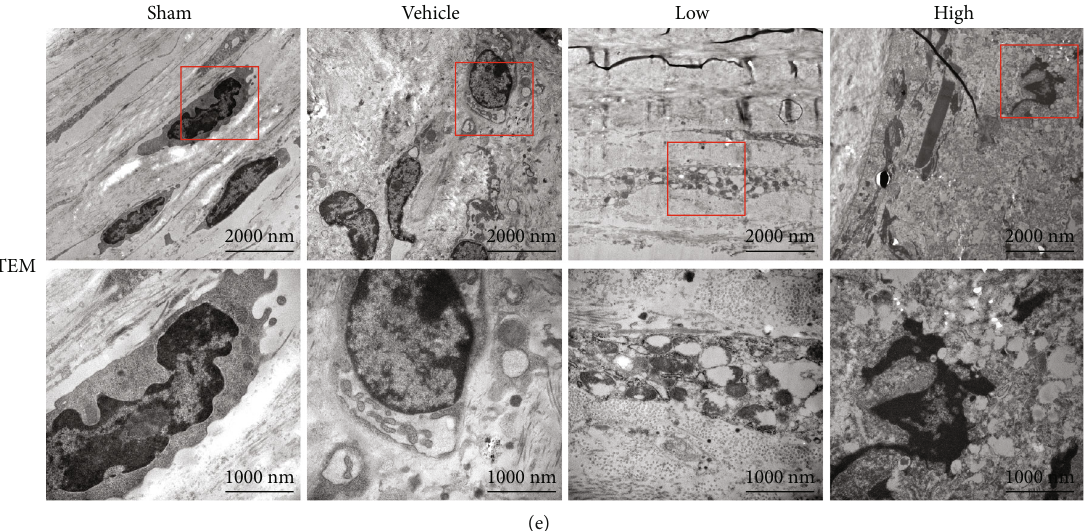
Figure 2: Tetrandrine (Tet) prevents Ti particle-induced chronic in fl ammation and osteolysis in vivo . (a) H&E-stained images of the tissue specimen sections in each group observed via light microscopy. (b) Membrane thickness were quanti fi ed. (c) TRAP-stained images of the tissue specimen sections in each group observed via light microscopy. (d) TRAP-positive cells were quanti fi ed. (e) Transmission electron microscopy (TEM) images of cells in the implanted bones and pouches around Ti particles. The air pouch membrane thickness ( μ m) and TRAP-positive cell numbers were quanti fi ed ( ∗ p < 0 : 05 , ∗∗ p < 0 : 01 compared with the vehicle group; n = 5 per group). M: membrane; B: bone; H&E: hematoxylin and eosin; TRAP: tartrate-resistant acid phosphatase. The red arrows indicate TRAP-positive